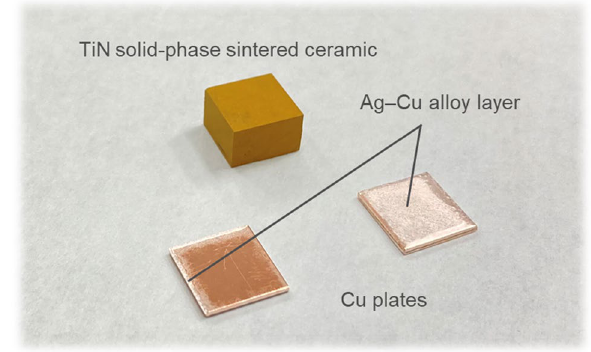
Fig. 3 Appearance of the TiN solid-phase sintered ceramic and Cu plates brazed with a Ag–Cu eutectic brazing foil after heating at 850 °C for 0.5 h